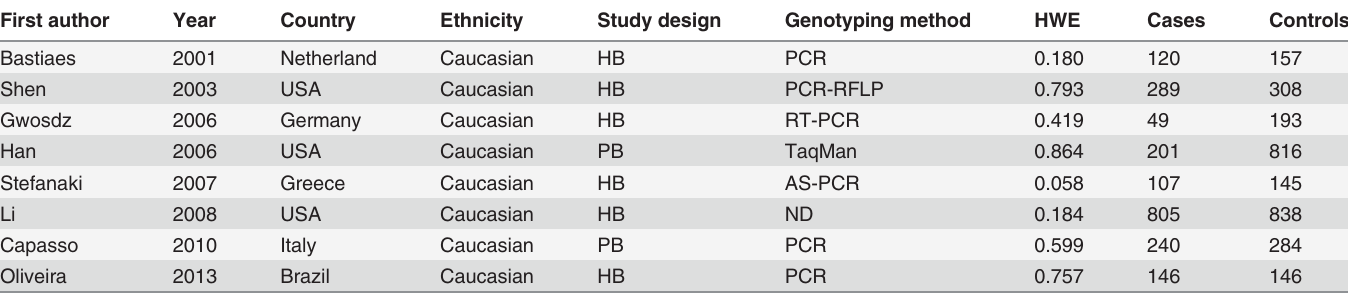
Table 1. Characteristics of studies included in the meta-analysis.